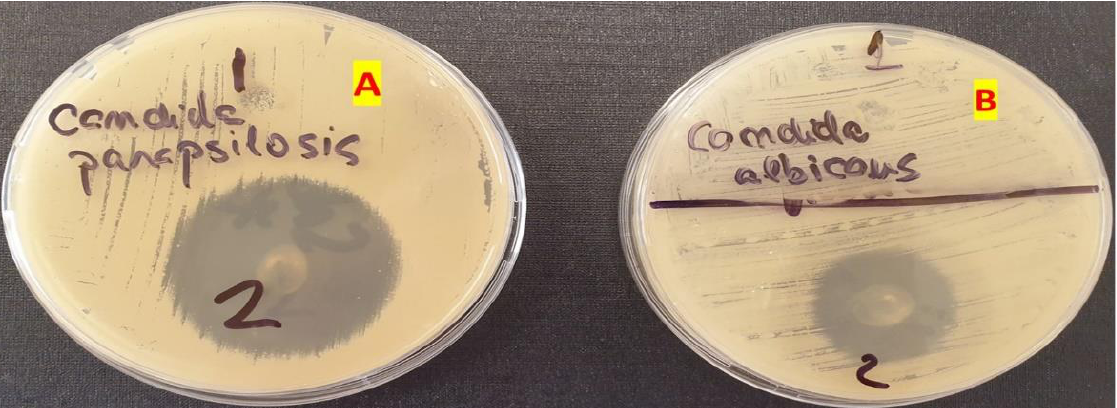
Figure 9. The inhibition of Candida parapsilosis ( A ) and Candida albicans ( B ) using the blank gel (1) and the optimized MIC gel (2).